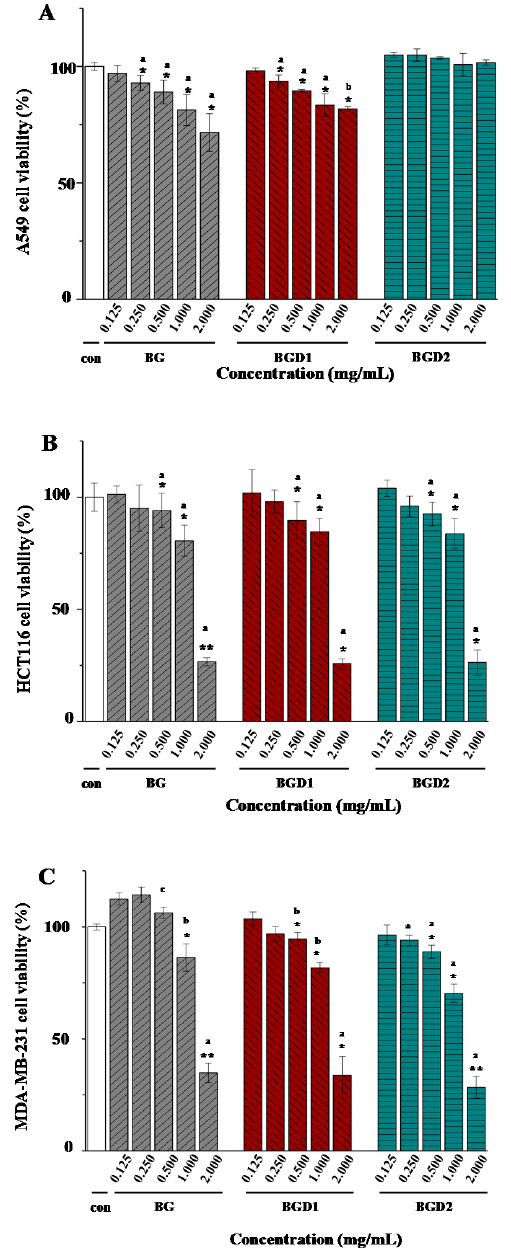
Figure 5. In vitro anti-cancer activities of Qingke β -glucans against A549 ( A ); HCT116 ( B ); and MDA-MB-231 ( C ) cells. BG , Qingke β -glucan; BGD1 , Qingke β -glucan with acid hydrolysis for 10 min; BGD2 , Qingke β -glucan with acid hydrolysis for 20 min; The error bars are standard deviations; the differences of cell viability between sample and control groups are significant at * p < 0.05, ** p < 0.01; significant ( p < 0.05) differences of cell viability among BG, BGD1, and BGD2 are shown by data bearing different letters